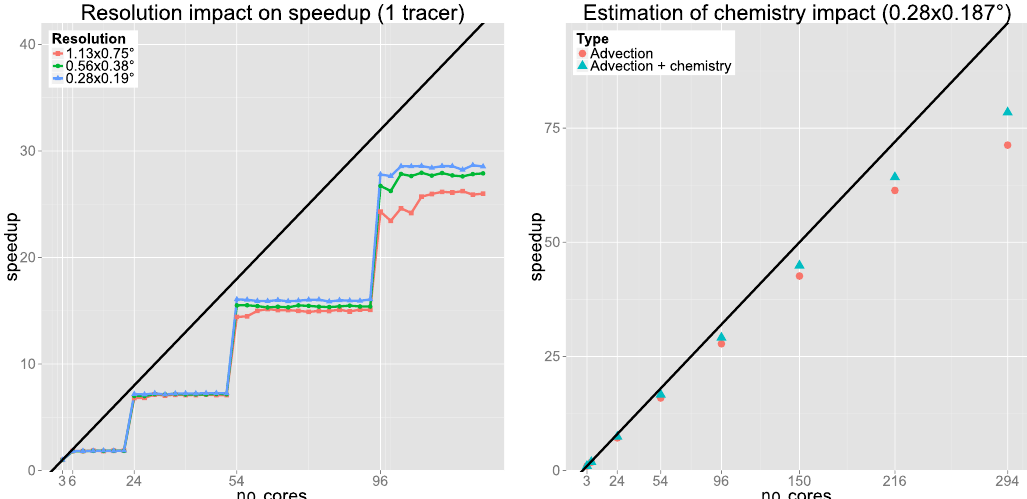
no. no. Figure 18. Speedup up to 126 cores (left) and 294 cores (right). The left plot shows the impact of grid resolution for smaller configurations. The right plot shows both the advection performances and an estimation of the chemistry impact on scalability. Resolutions used are 1 . 125 ◦ × 0 . 75 ◦ , 0 . 56 ◦ × 0 . 376 ◦ and 0 . 28 ◦ × 0 . 188 ◦ . Both figures use non-divergent winds from Sect. 3 over a full period with a CFL of